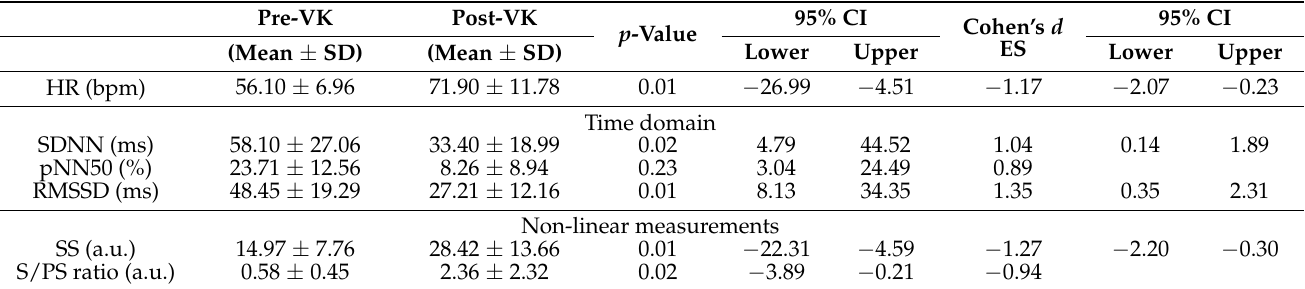
Table 1. Central fatigue before and after the VK trail running